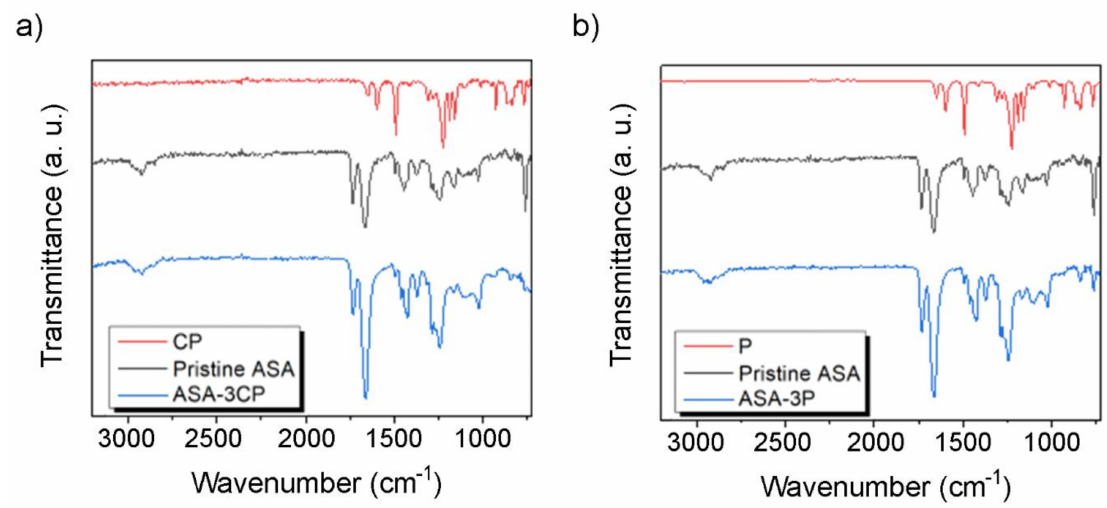
Figure 5. ATR spectra of ( a ) CP, pristine ASA, and ASA-3CP, and ( b ) P, pristine ASA, and